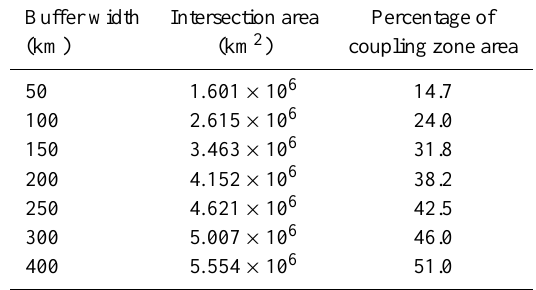
Table 1. Calculated areas and fraction of coupling zone for chosen buffer widths around fracture-zone